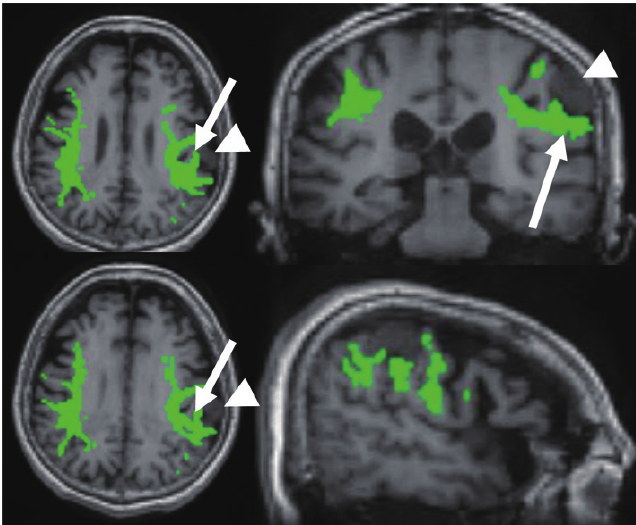
Fig. 2. DTI images of the SLF before surgery. The SLF (green) was constructed in axial (Panel 1) and coronal (Panel 2) MRI as described in the Methods section. The left SLF ran around the tumor (white arrowhead), and one branch of the left SLF (white arrow) was highly compressed by the